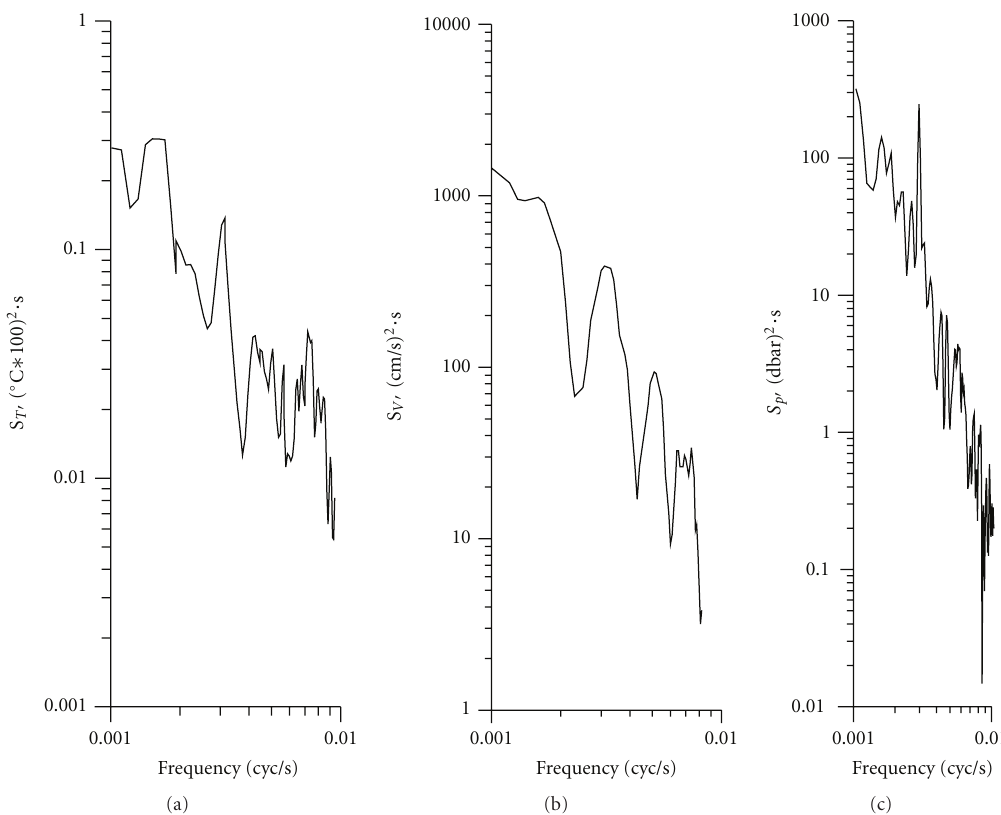
Figure 5: (a) spectrum of the temperature fluctuations in the high-frequency range; (b) spectrum of the current velocity fluctuations in the high-frequency range; (c) spectrum of the pressure fluctuations at the bottom in the high-frequency range.